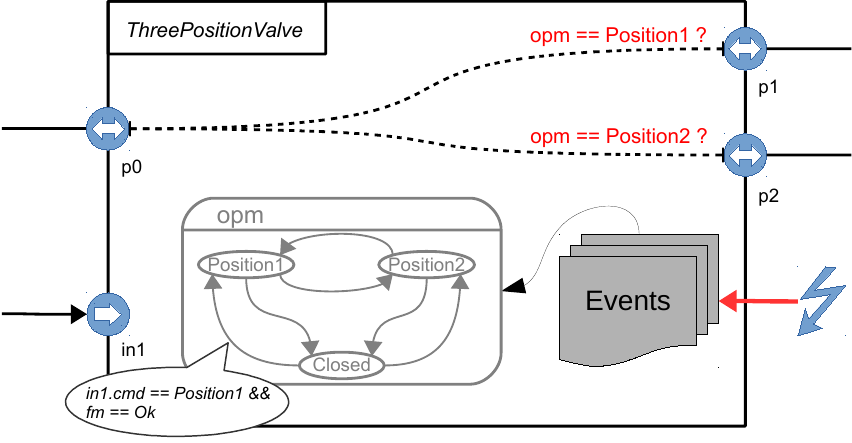
Figure 2. Sketch of a smartIflow